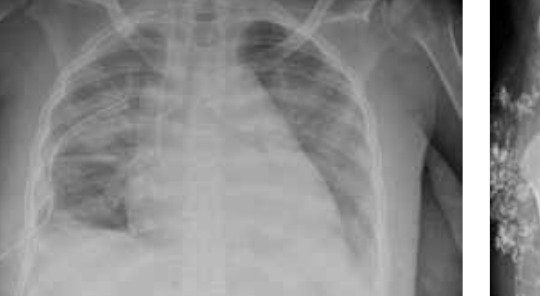
Fig. 1. Chest radiograph demonstrates cardiomegaly with a right pleural effusion.